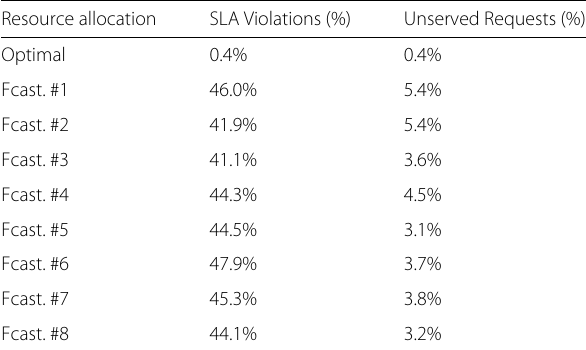
Table 5 Percentage of SLA violations and unserved requests over total number of requests for the 24 h test interval, based on the resource allocation of Table